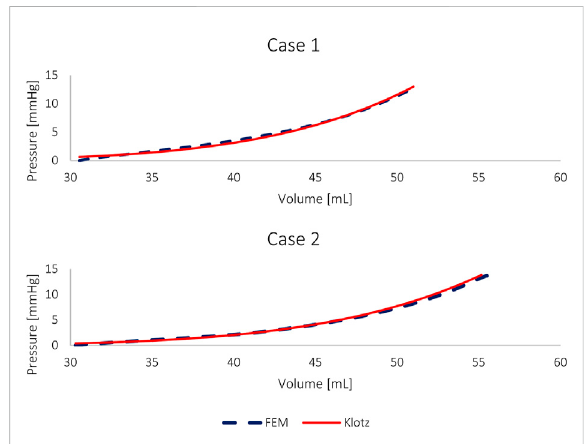
FIGURE 5 The pressure-volume curves of the FE models and the corresponding Klotz curves of HFpEF models without geometric